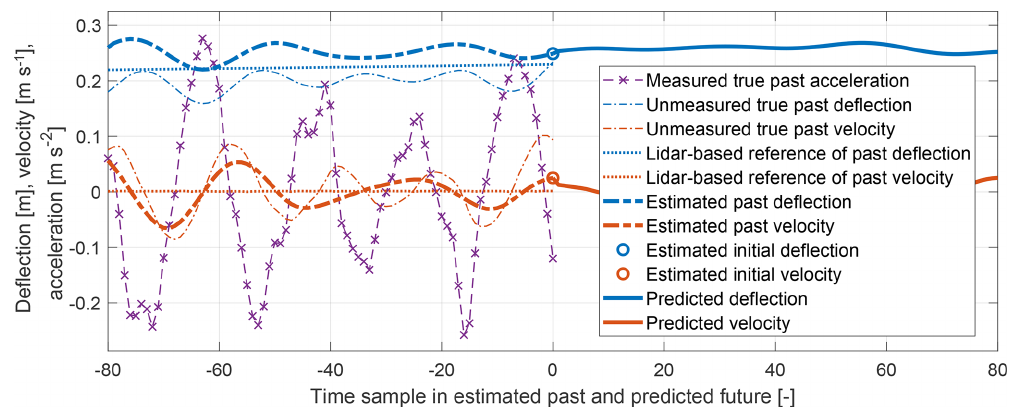
Figure 8. Wind turbine tower quantities ordered by occurrence in the estimation and control process: measured, unmeasured, lidar-based reference (see Sect. 4.2), estimated, and predicted. Negative time samples are estimation horizon of the MHE; positive time samples are prediction horizon of the MPC.